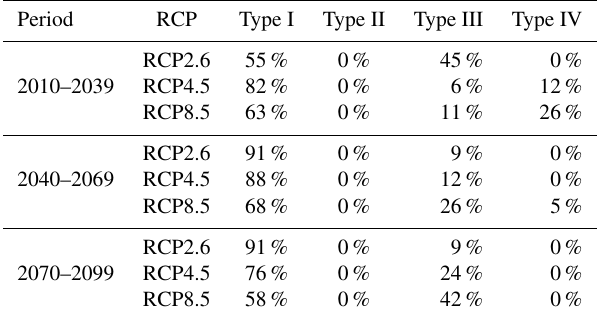
Table 4. Percent of social risk cases falling in each type (I, II, III or IV) grouped by period and RCP.